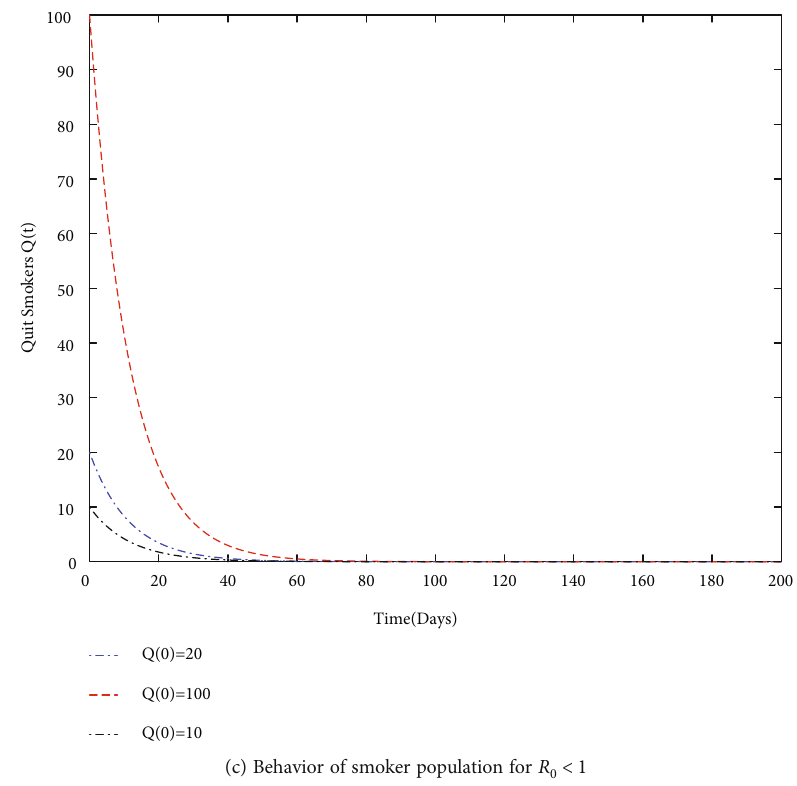
Figure 2: Di ff erent initial size of compartments and its long-term behavior for R